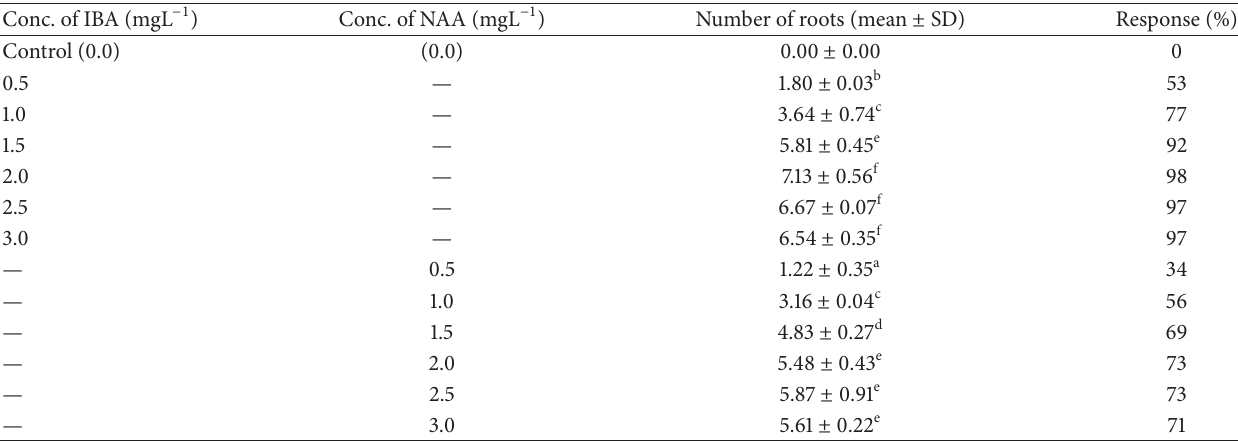
Table 4: Effect of auxins (IBA, NAA) on in vitro root induction from in vitro raised shoots after 4 weeks. Conc. of IBA (mgL −1 ) Conc. of NAA (mgL −1 ) Control